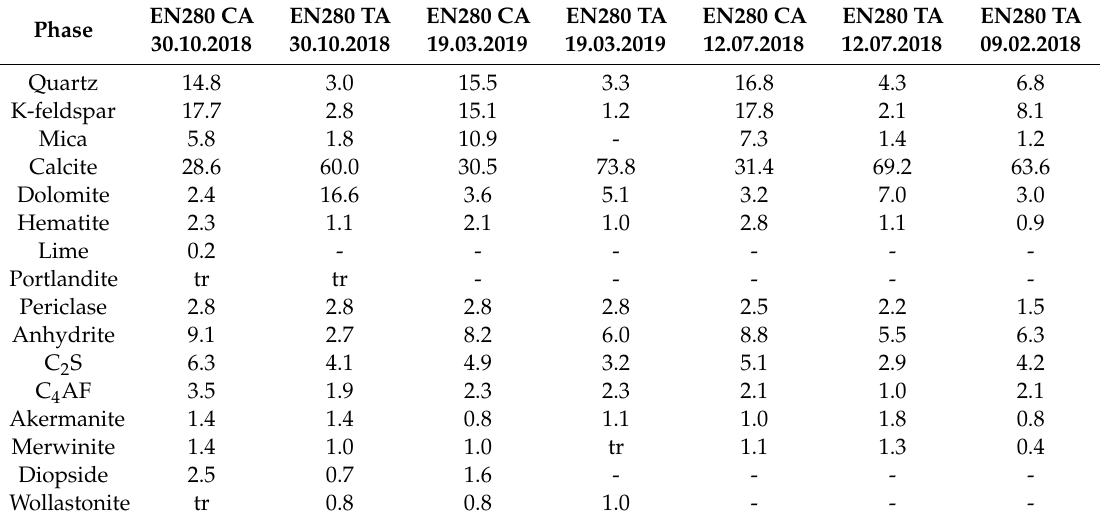
Table 2. Phase composition of EN280 (TA,